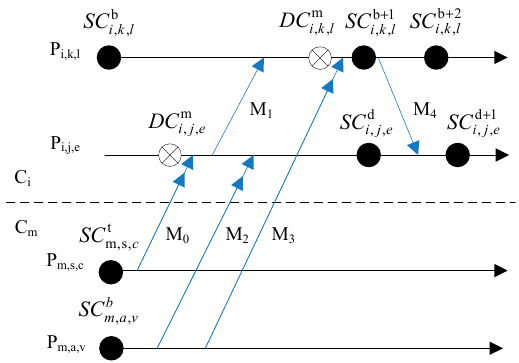
Figure 5. An example of the coexistence of multiple same cluster checkpoints.